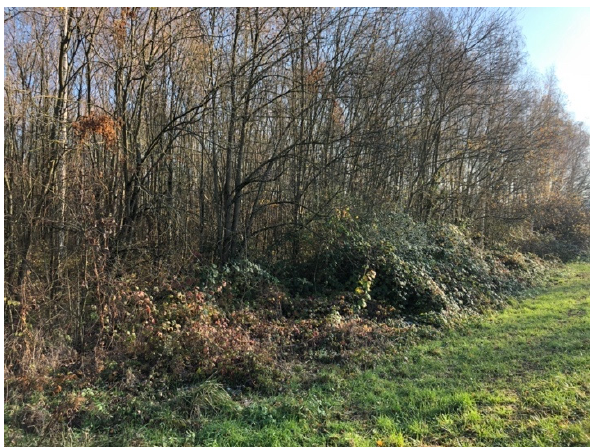
Figure 15. Photo of the woodland shown in Figures 13 and 14